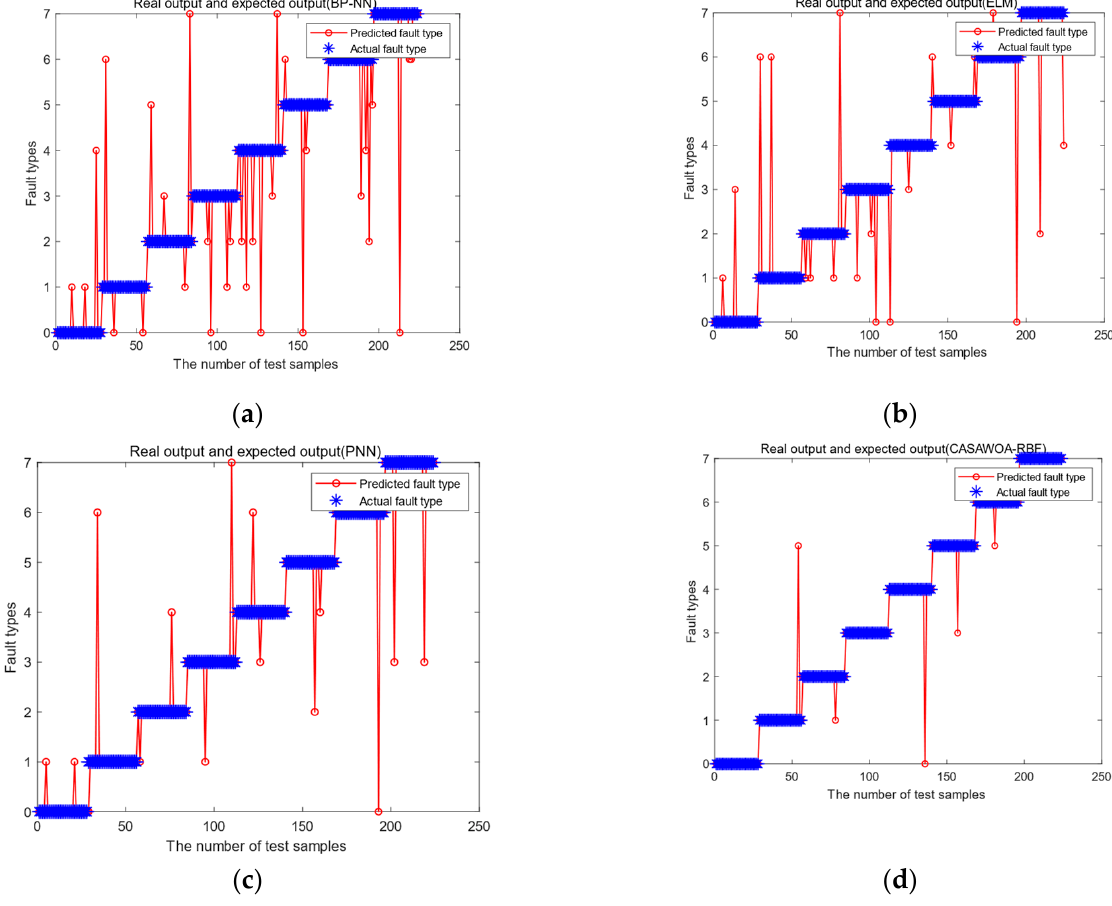
Figure 9. The results of fault diagnosis of the existing neural network: ( a ) BP-NN; ( b ) ELM; ( c ) PNN; ( d ) CAWAWOA-RBF. Table 11. Comparison of the recall for each model.